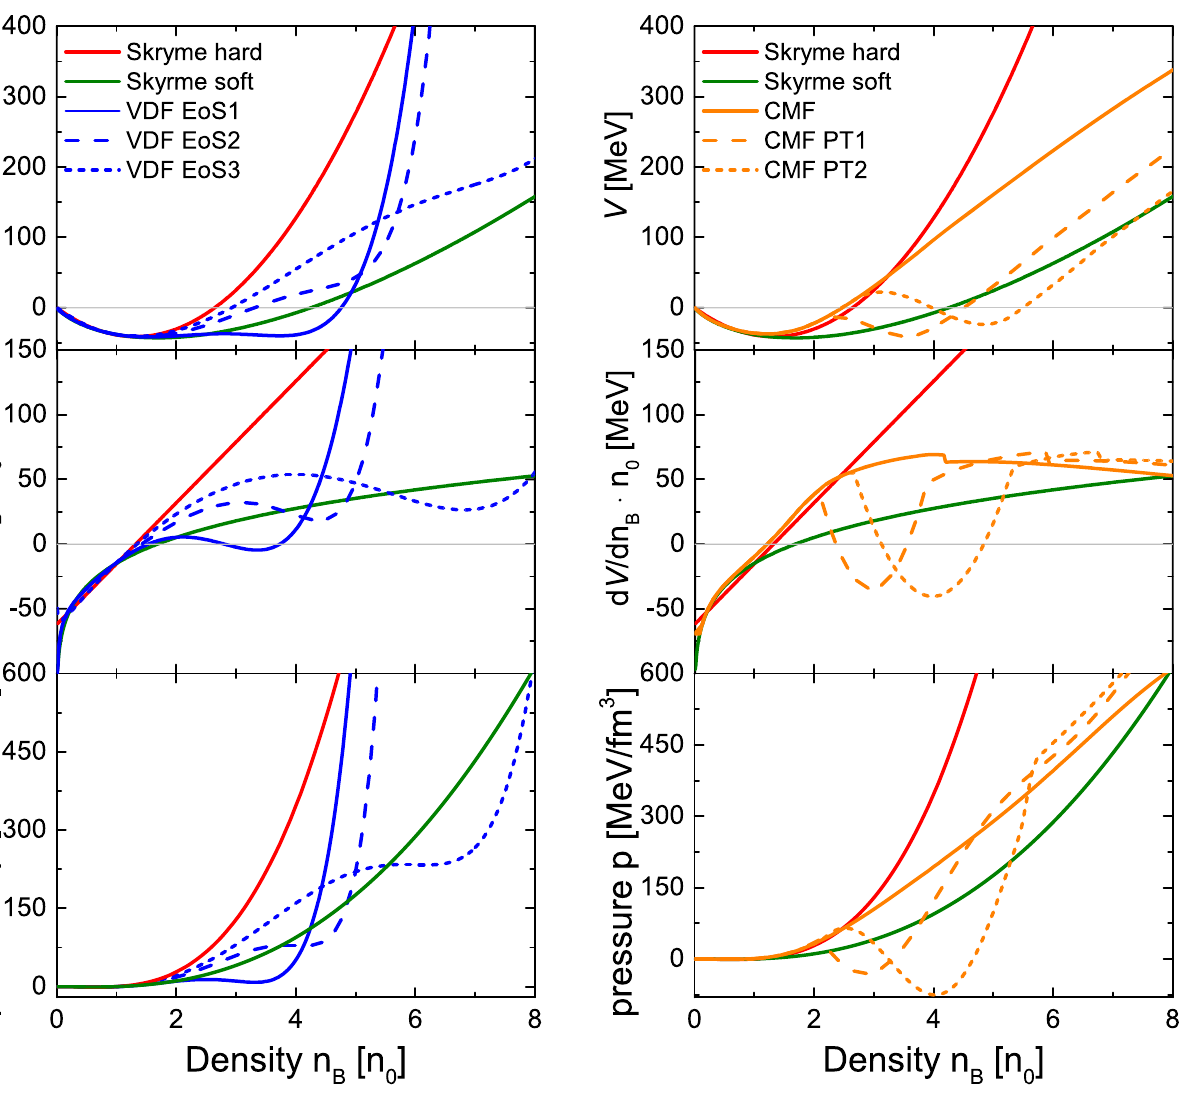
Fig. 2 Upper plot: Field energy per baryon of three versions of the CMF EoS compared to those from the hard and soft Skyrme parametrizations. Middle plot: derivative of the field energy per baryon with respect to the baryon density, entering the calculation of the MD- forces, for the same EoSs. While the standard CMF essentially corre- sponds to a smooth transition with only a very minor phase transition at ρ B ≈ 4 ρ 0 , the two scenarios PT1 and PT2 show significant unstable regions at different densities. Lower plot: pressure as a function of the baryon density for all CMF equations of state, compared to the hard and soft Skyrme